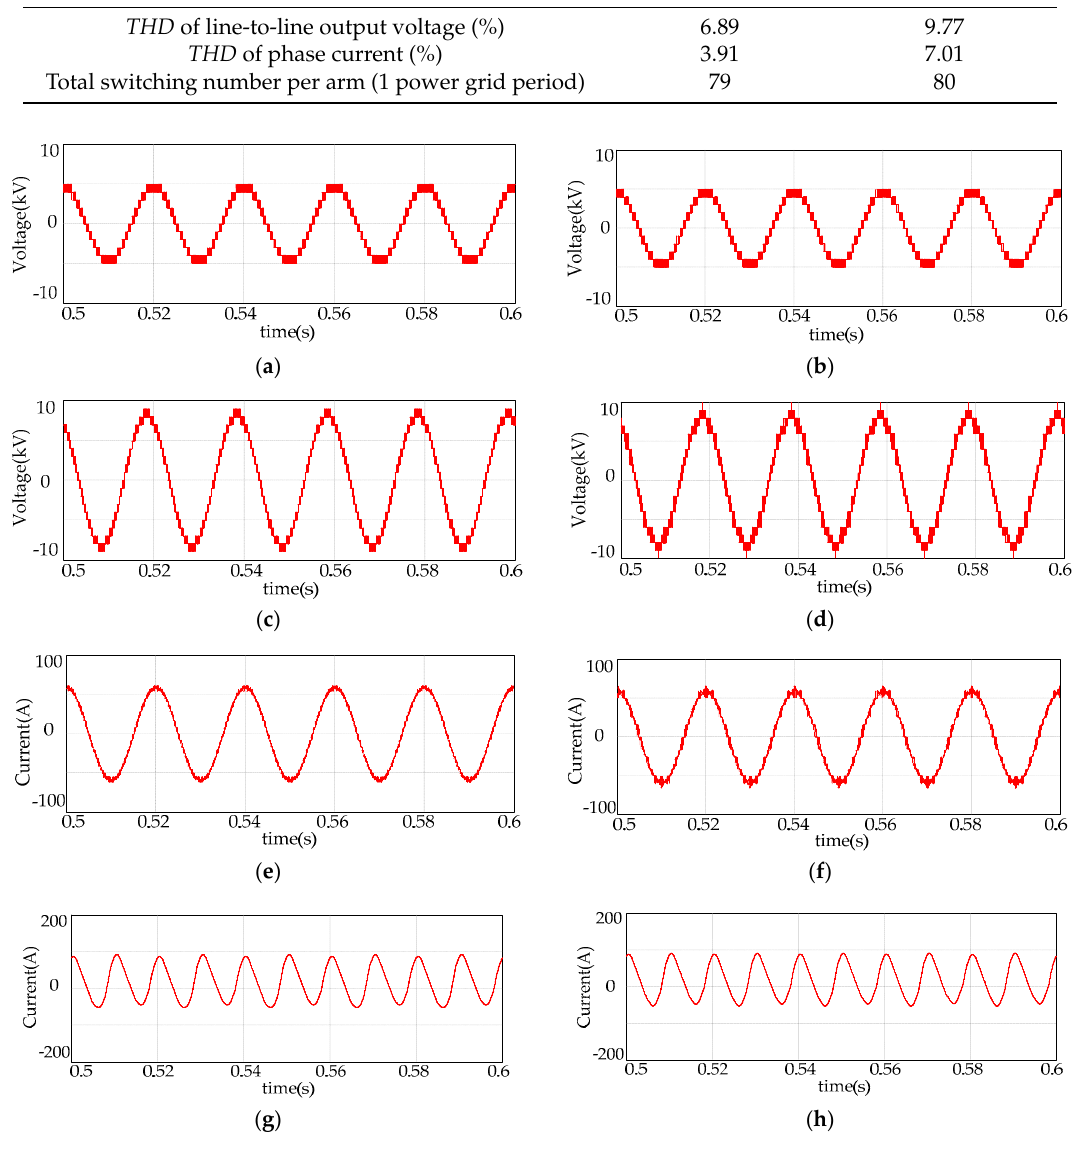
Figure 5. Comparison of simulation waveforms between DCPDPWM and phase-shifted carrier pulse-width modulation (PSCPWM) methods with the circulating current harmonics cancellation scheme: ( a ) phase voltage of DCPDPWM; ( b ) phase voltage of PSCPWM; ( c ) line-to-line voltage of DCPDPWM; ( d ) line-to-line voltage of PSCPWM; ( e ) phase current of DCPDPWM; ( f ) phase current of PSCPWM; ( g ) circulating current of PDPWM; and ( h ) circulating current of PSCPWM.